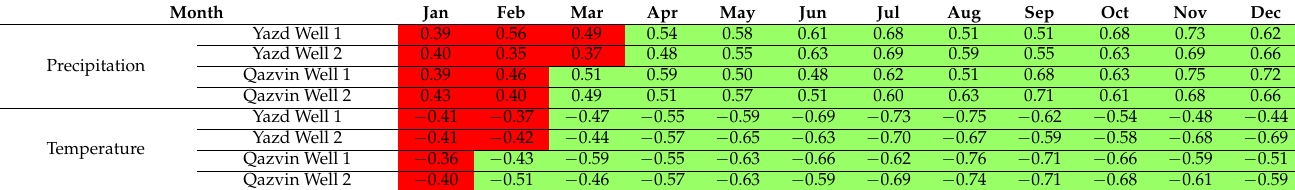
Table 8. Correlation coefficient between changes in groundwater level and meteorological parameters.